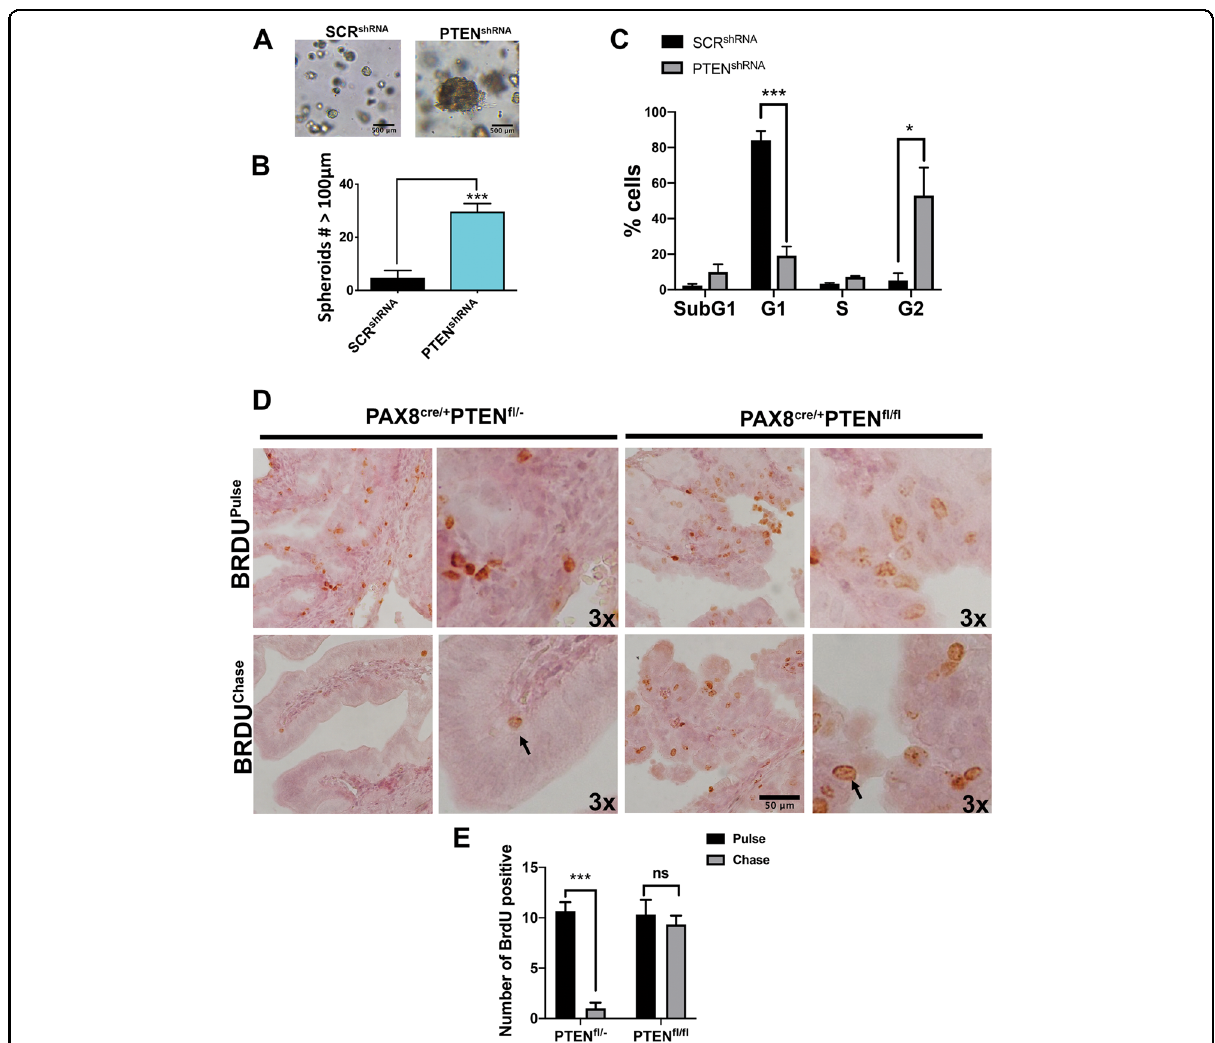
Fig. 2 Loss of PTEN stimulates spheroid growth and enhances BrdU retention in a transgenic mouse model of fallopian tube-derived cancer. A MOE SCR shRNA and PTEN shRNA cells were grown in 50% matrigel and imaged using NIKON Eclipse TS100. B Number of spheroids with a diameter above 100 μ m over the total amount of aggregates of three replicates in three independent experiments was quanti fi ed using Celigo (Nexcelom) (*** p < 0.001). C SCR shRNA or PTEN shRNA were permeabilized and stained with PI for cell cycle analysis and analyzed using Cellometer K2 (Nexcelom). Statistical analysis was performed using Sidak ’ s multiple comparison in GraphPad. * p < 0.05; *** p < 0.001. D Mice were injected with BrdU and tissues were collected right after (pulse) injection or 2 weeks later (chase). Immunohistochemistry (IHC) using speci fi c antibodies targeting BrdU were used in control PAX8 cre/ + PTEN fl / + and homozygous mice PAX8 cre/ + PTEN fl / fl . Scale bar represents 50 μ m. The 3× label indicate a further magni fi cation to show difference in cell size; arrows indicate larger cells. E Number of cells with positive BrdU staining were counted in three different fi elds for three independent experiments. Two-way ANOVA with multiple comparisons was applied. p -value*** =